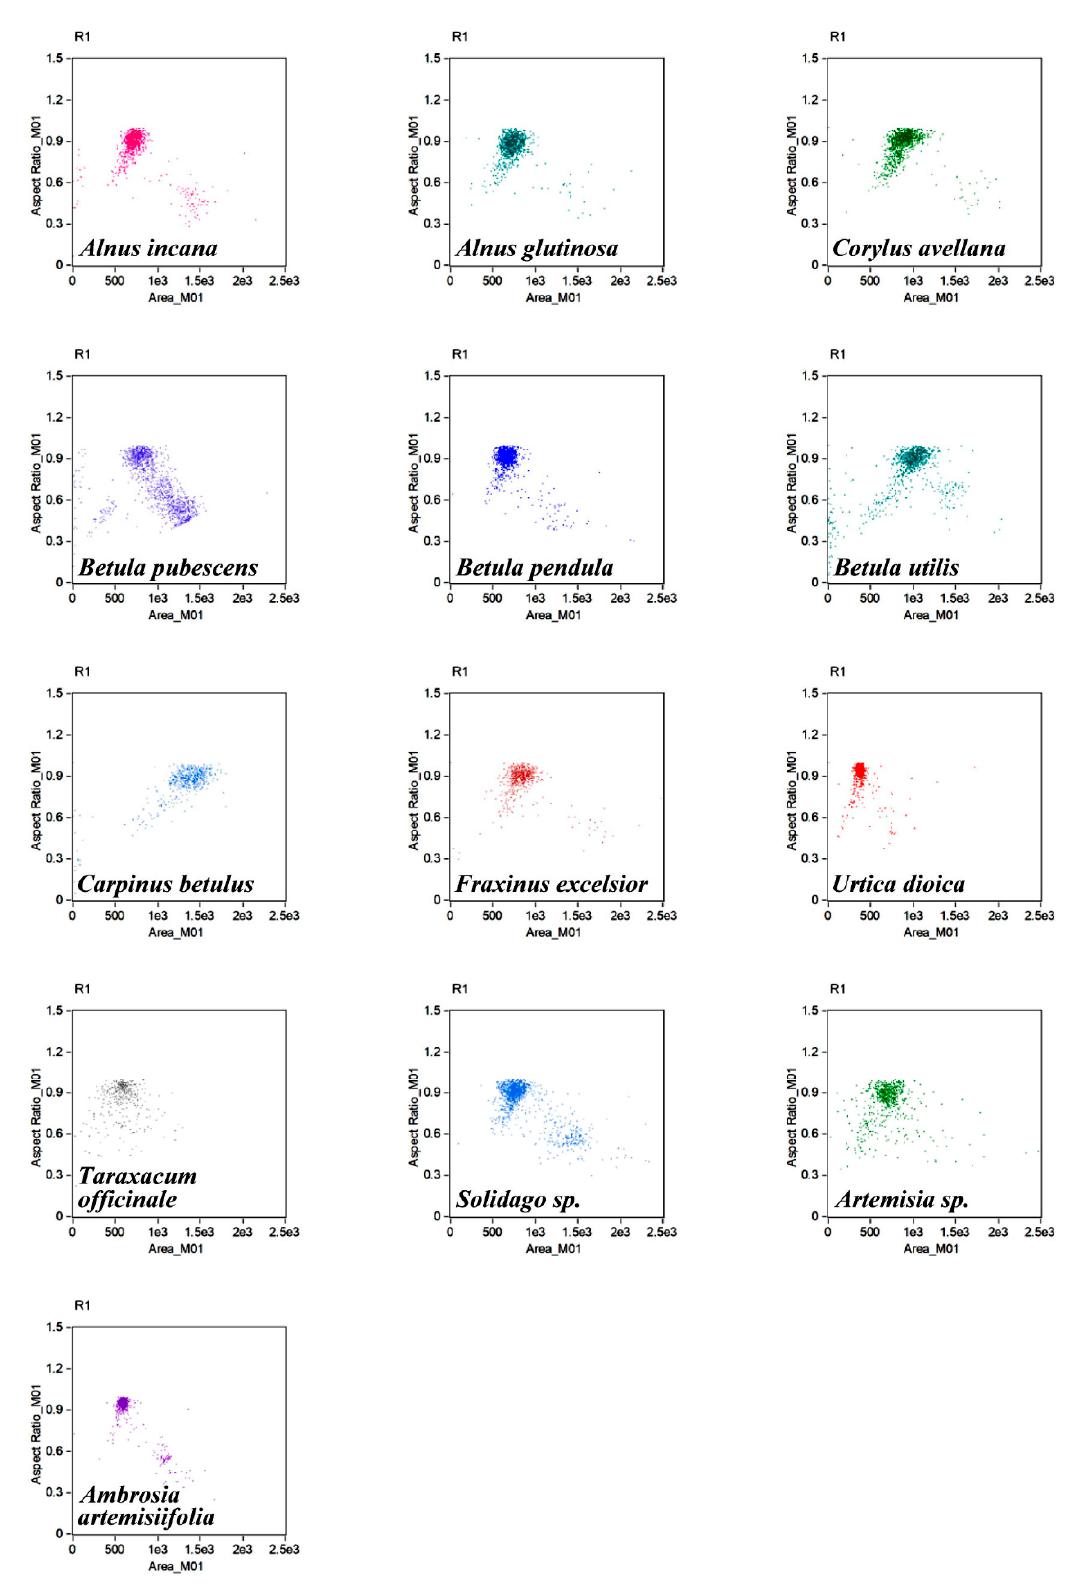
Figure 3. Characterisation of pollen grain populations of species studied using IFC. The best-focused objects (R1) were gated according to the parameter ‘aspect ratio’ (channel 1, BF, y -axis) versus the ‘area’ parameter (channel 1, BF, x -axis).